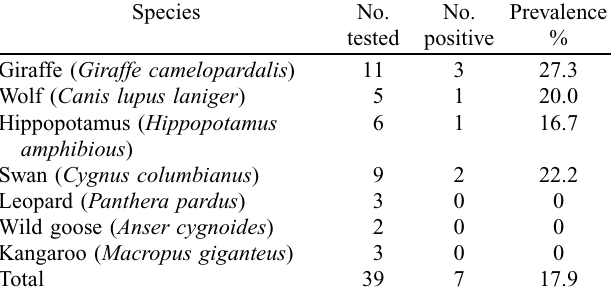
Table 2. Prevalence of Toxoplasma gondii infection in goats, water buffaloes and domestic cattle, determined by indirect hemaggluti- nation (IHA) test in Jiangxi province, China in 2016. Goats Water buffaloes